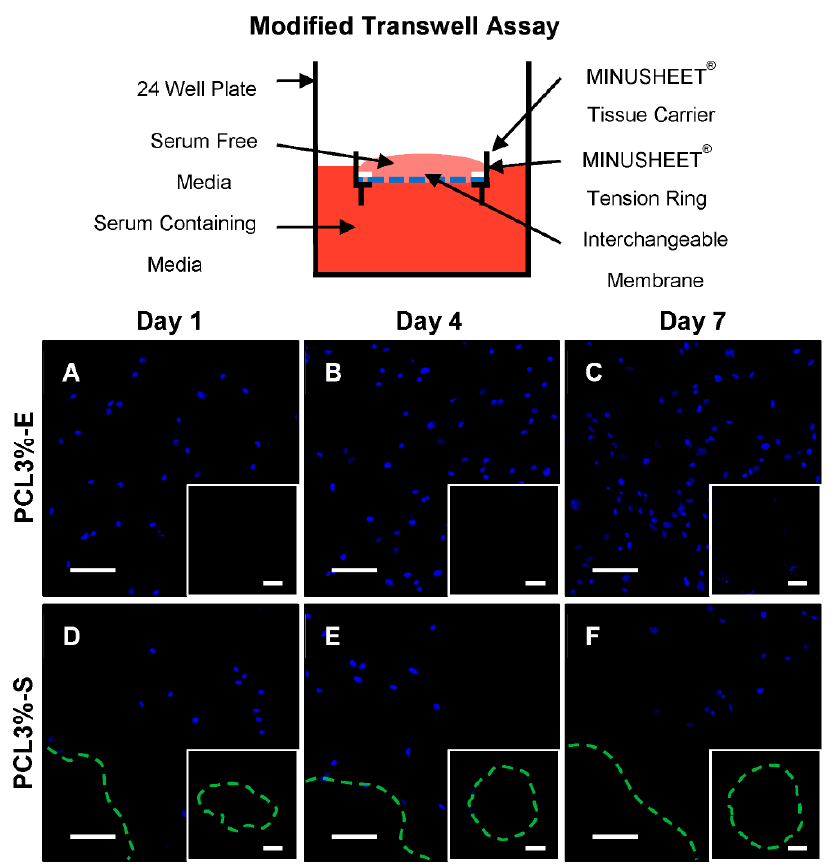
Figure 5. PCL3%-E barrier function assessment. Schematic of assay set up, MINUSHEET ® tissue carrier, containing ( A – C ) PCL3%-E or ( D – F ) PCL3%-S. The bottom of the well (dark red) had serum containing media and serum starved MSCs (10 3 cells / sample) (pink), were added to the top of the MINUSHEET ® tissue carrier. ( A – F ) Constructs were imaged from the top (main image) and bottom (insert). Green dashed line corresponds to the pore edge on laser cut samples. Scale bar: 100 μ m.